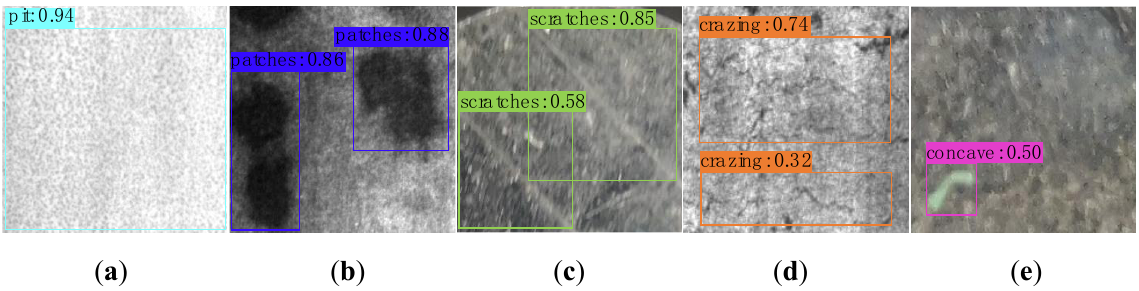
Figure 15. The test results of YOLOv3-ALL. (a) The defects of pit. (b) The defects of patch. (c) The defects of scratch. (d) The defects of crack. (e) The defects of concave